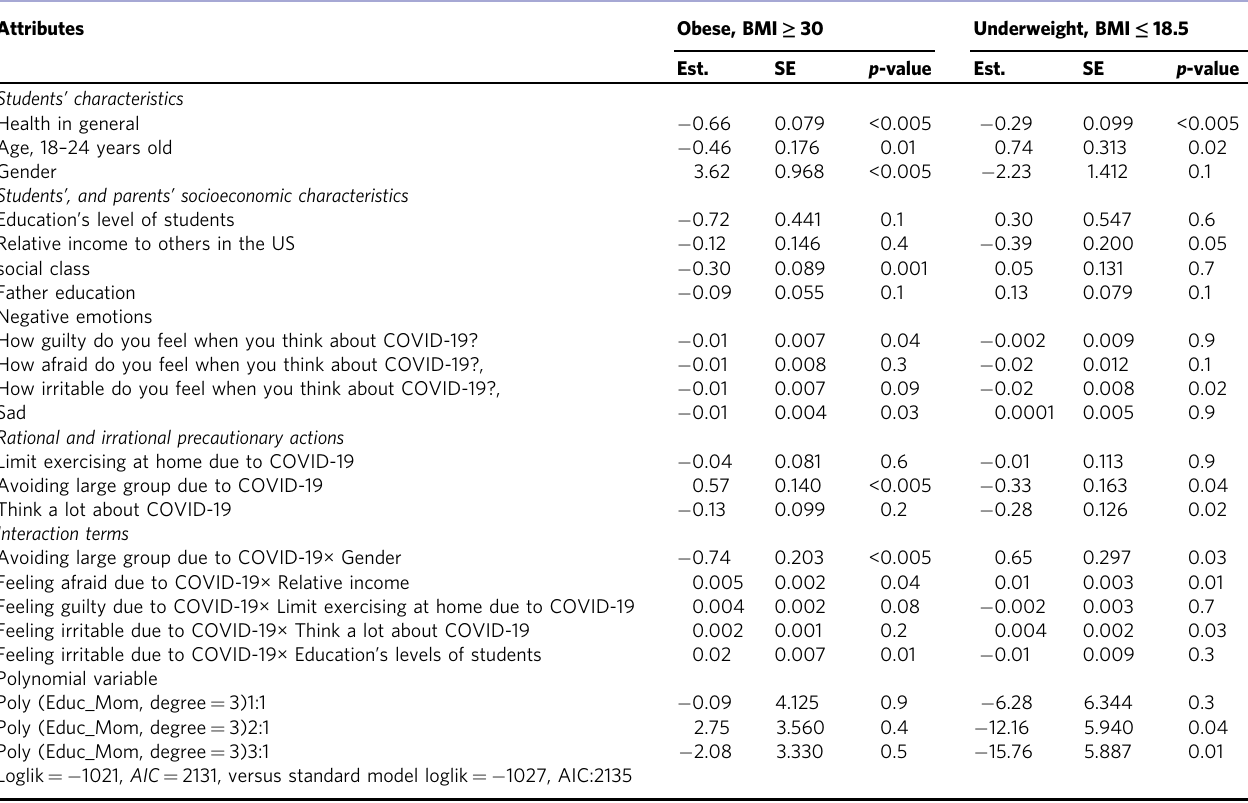
Table 2 Associated factors to underweight and